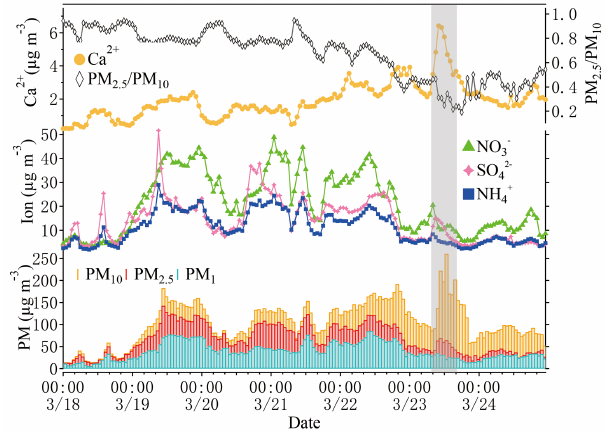
Figure 2. Time series of the concentrations of PM 10 , PM 2 . 5 , PM 1 and the main water-soluble ions of PM 2 . 5 (NO − Ca 2 + ) measured in Nanjing during 18–23 March